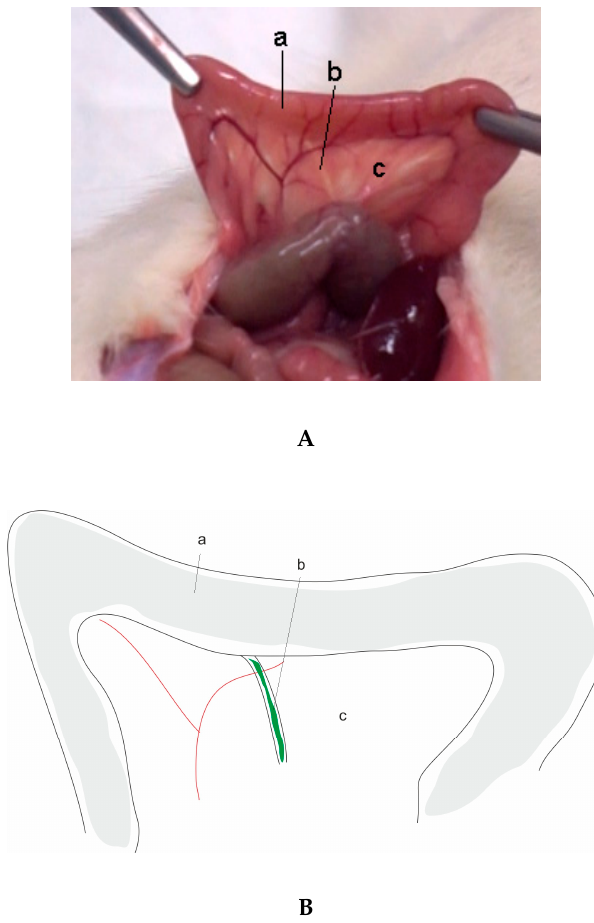
Figure 1. ( A ) Rat pancreas anatomy. Image: The pancreas of an adult rat showing the duodenum and common biliopancreatic duct. Rodent pancreas is soft and diffuse compared with the human pancreas. Photo provided by authors lab. a- duodenum; b- common biliopancreatic duct; c- pancreas. ( B ) Schematic showing the anatomy of rat pancreas. Image: picture showing the schematic anatomy of the pancreas, duodenum, and common biliopancreatic duct. a- duodenum; b- common biliopancreatic duct; c- pancreas. Int. J. Mol. Sci. 2019 , 20 , x